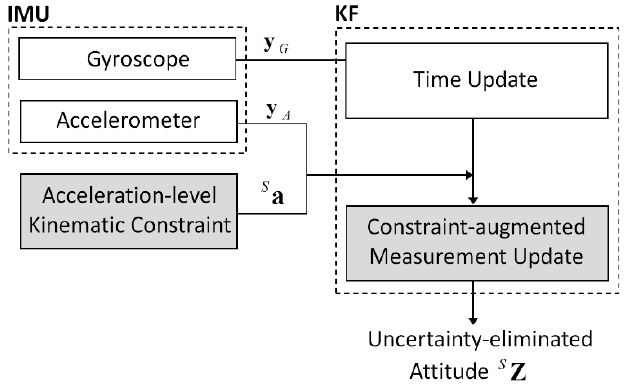
Figure 2. Overview of the proposed constraint-augmented Kalman filter.